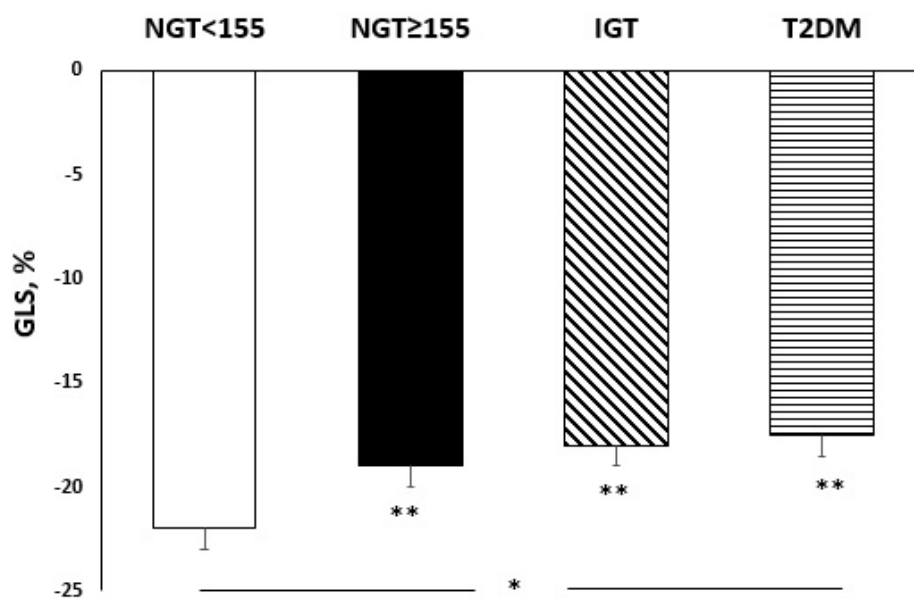
Figure 3. Global longitudinal strain (%) according to different groups of glucose tolerance. * p < 0.0001 (ANOVA test); ** p < 0.0001 vs. NGT < 155 (Bonferroni post hoc test). Moreover, from the first to the fourth group there was a progressive reduction in GWE (Figure 4) ( p < 0.0001) and a progressive increment in GWW ( p < 0.0001). In detail, NGT ≥ 155 exhibited a worsening of GWE in comparison with NGT < 155 ( p = 0.027), but similar to IGT and diabetic patients.